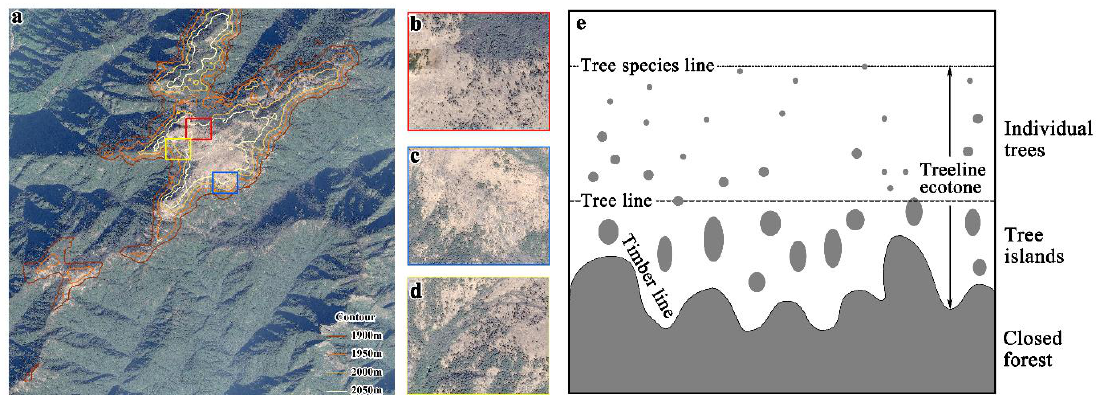
Figure 1. Tree line ecotone concept (image is true-color composite downloaded from Google Earth; spatial resolution 0.53 × 0.53 m; acquired on 23 December 2014). ( a ) Full view of alpine meadow in Wuyishan National Park (study area). ( b ) Close-up of red box in ( a ). ( c ) Close-up of blue box in panel ( a ). ( d ) Close-up of yellow box in panel ( a ). ( e ) Illustration of ecosystem concept; it is a modified illustration from Korner and Paulsen’s research [15].